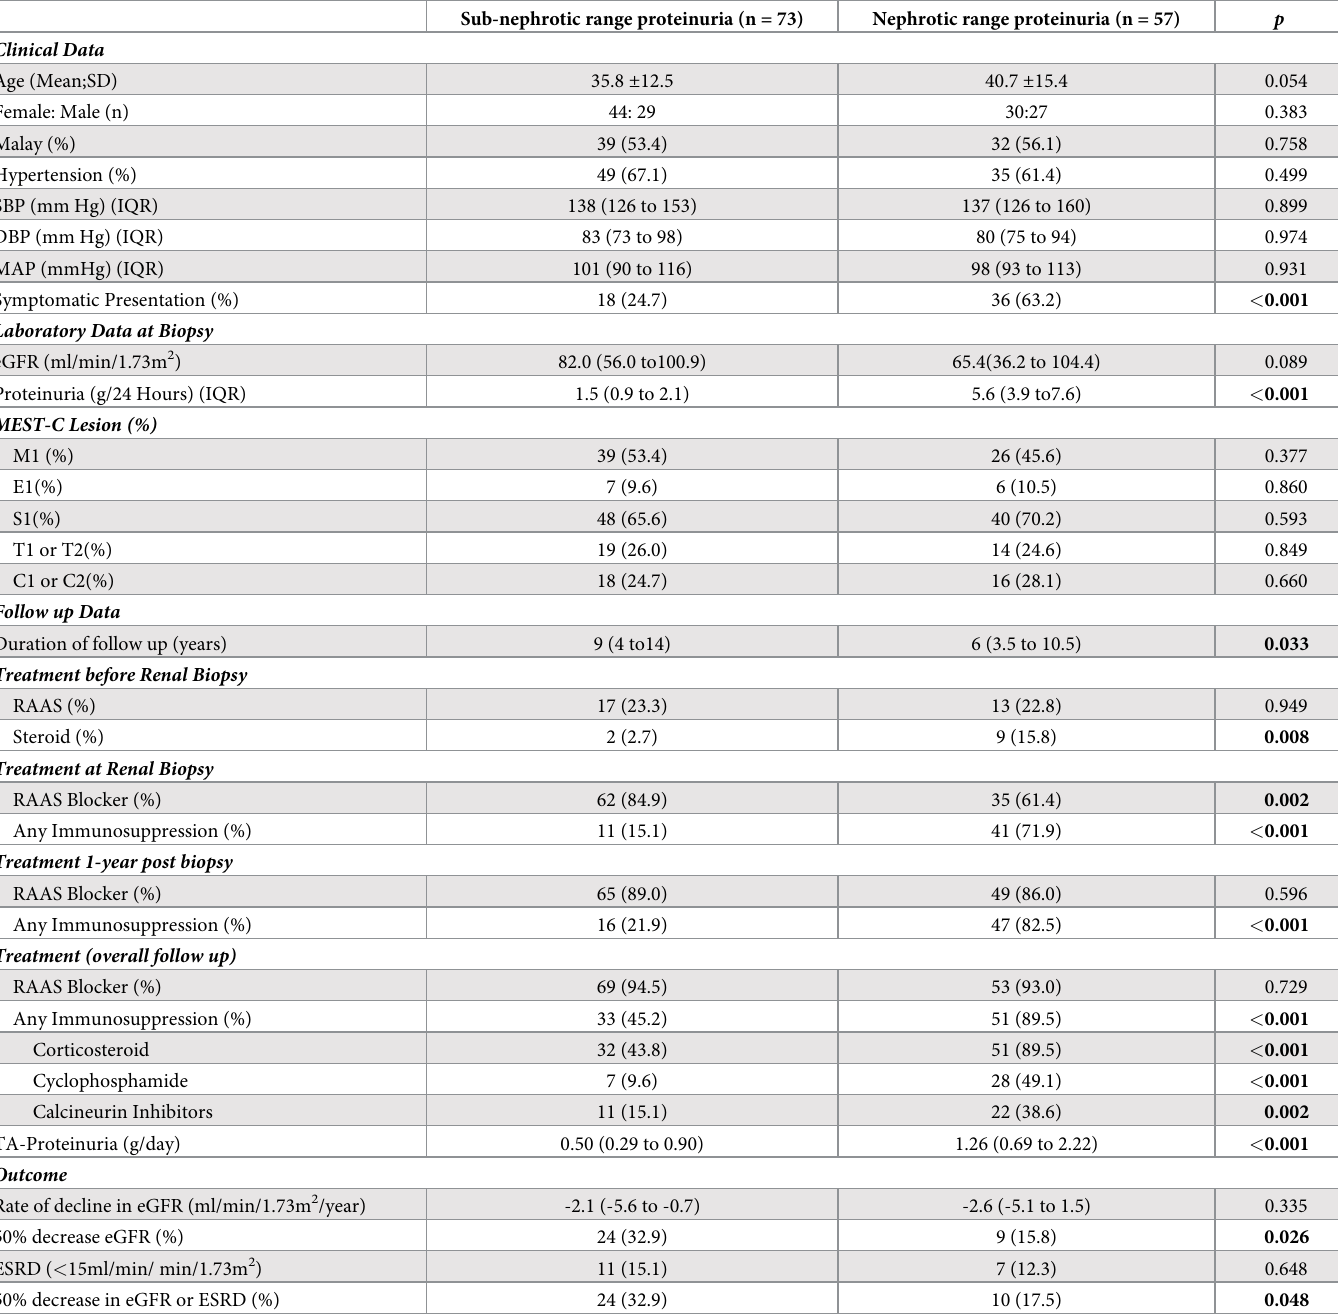
Table 5. Clinical, laboratory and histological characteristics of patients with IgA nephropathy presenting with nephrotic range proteinuria and sub-nephrotic